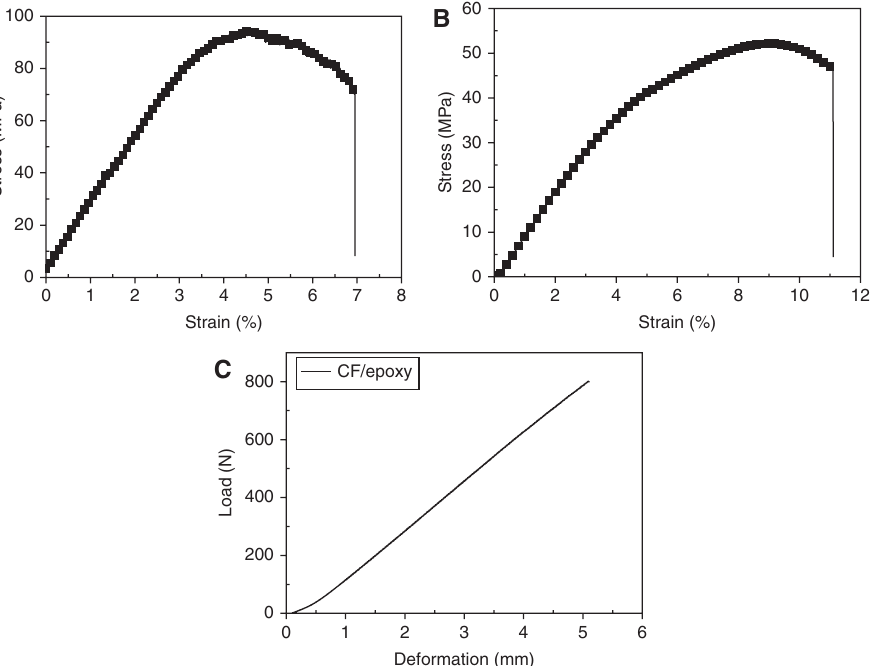
Figure 2: Fundamental mechanical performance of the used materials in WCF/epoxy composites: (A) flexural and (B) tensile stress-strain curves of cured epoxy resin; (C) flexural load-deformation curves of WCF/epoxy composites.